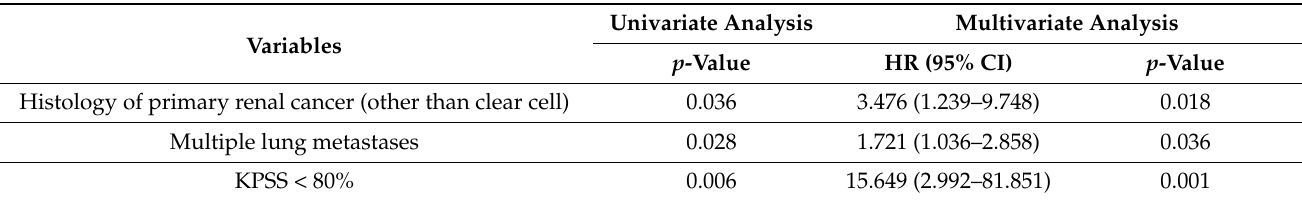
Table 4. Univariate and multivariate analyses for negative prognostic factors for disease-free survival after pulmonary metastasectomy and before lung disease